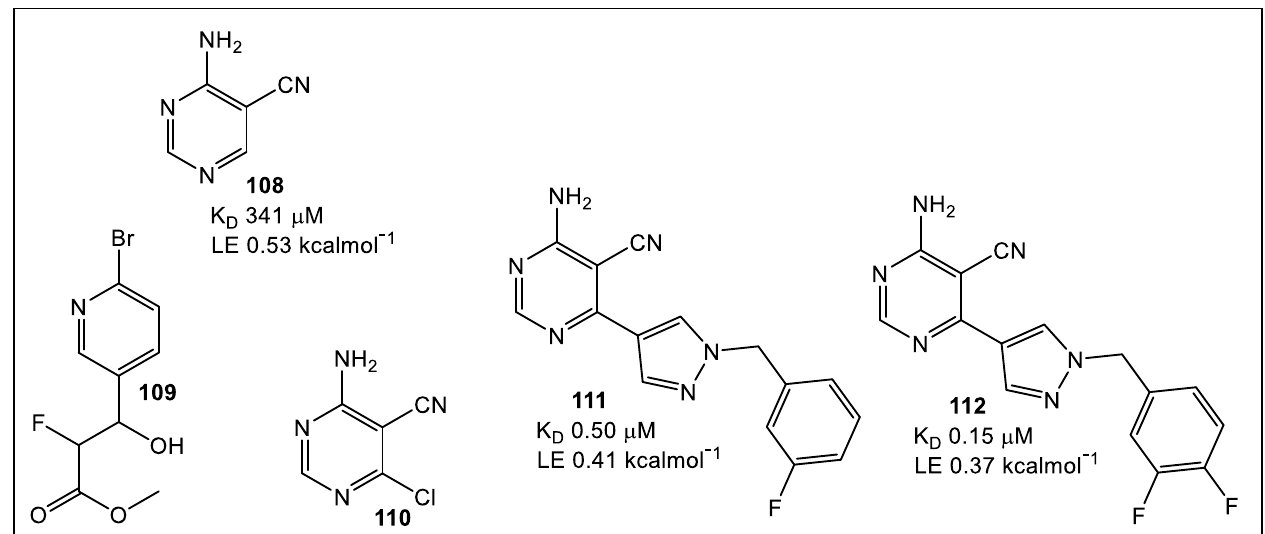
Figure 18. Fragment 108 demonstrated the highest ligand efficiency (LE). Fragment 108 with MabPurC revealed an interaction at the 6-postion of the pyrimidine in the “ribose binding pocket”. This binding position appeared to be tolerated since it also was functional 110 binding. Fragment expansion here permits the addition of the pyridine moiety of fragment 109 into fragment 108. How- ever, the introduction of a flexible linker was necessary for linkage of the fragments since they were almost perpendicular to each other. Synthesis of a library of a dozen compounds, where different linkers were explored, led to identification of compound 112 having the best binding affinity and LE